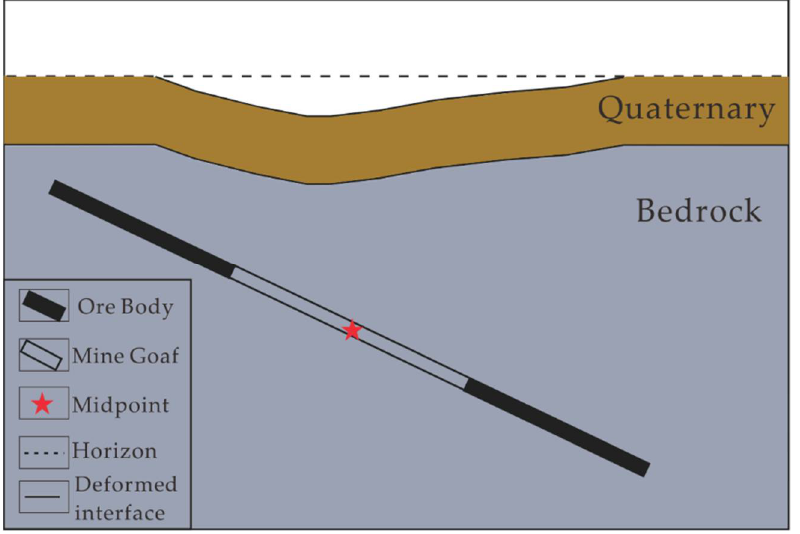
Figure 20. The schematic diagram of ground subsidence.